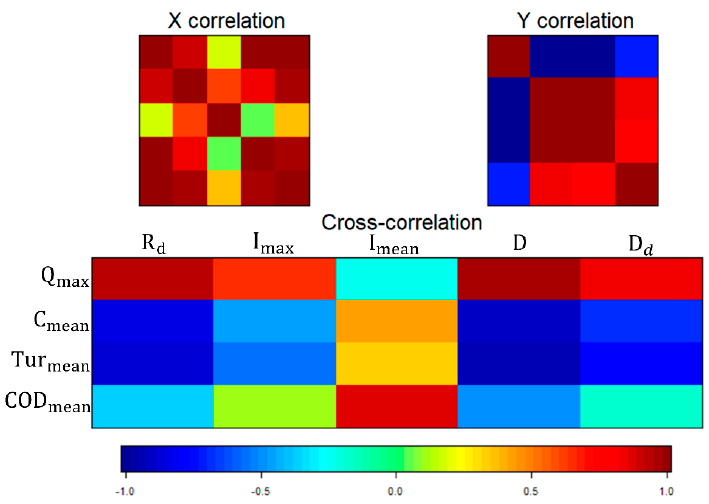
Figure A5. Correlation between rainfall and the CSO variables in the Coliseo CSO. The range of colors